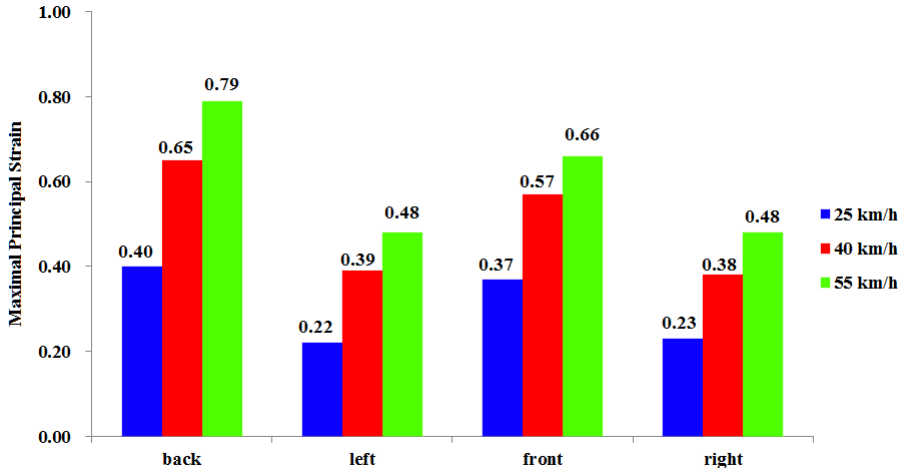
Figure 9. Maximal principal strain at different collision parameters.